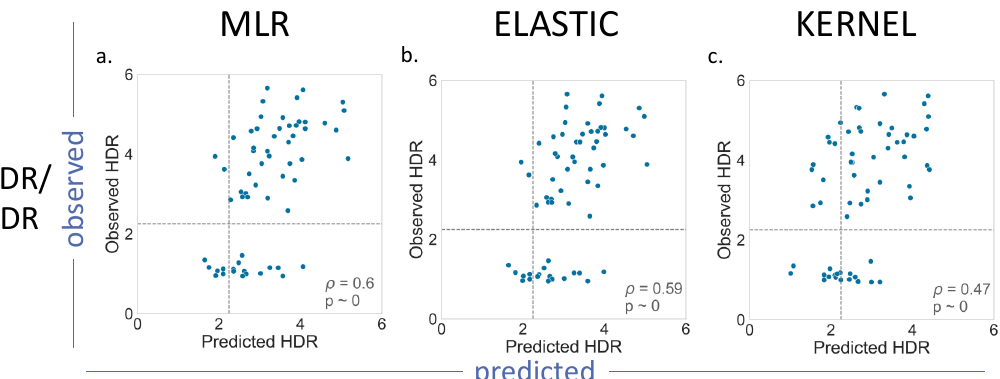
Figure 5. Observed vs. Predicted endophenotypes for the ( a ) MLR, ( b ) Elastic and ( c ) Kernel regressions. BRCA2 case. Here, the number of training/test combinations is lower than for BRCA1. The training and test sets correspond (see Materials and Methods) to 75% and 25%, respectively, of the HDR variant dataset for this protein. The dashed lines indicate the functionality thresholds defined in the literature for these assays and used in this work to binarize the prediction output into benign/pathogenic classes.